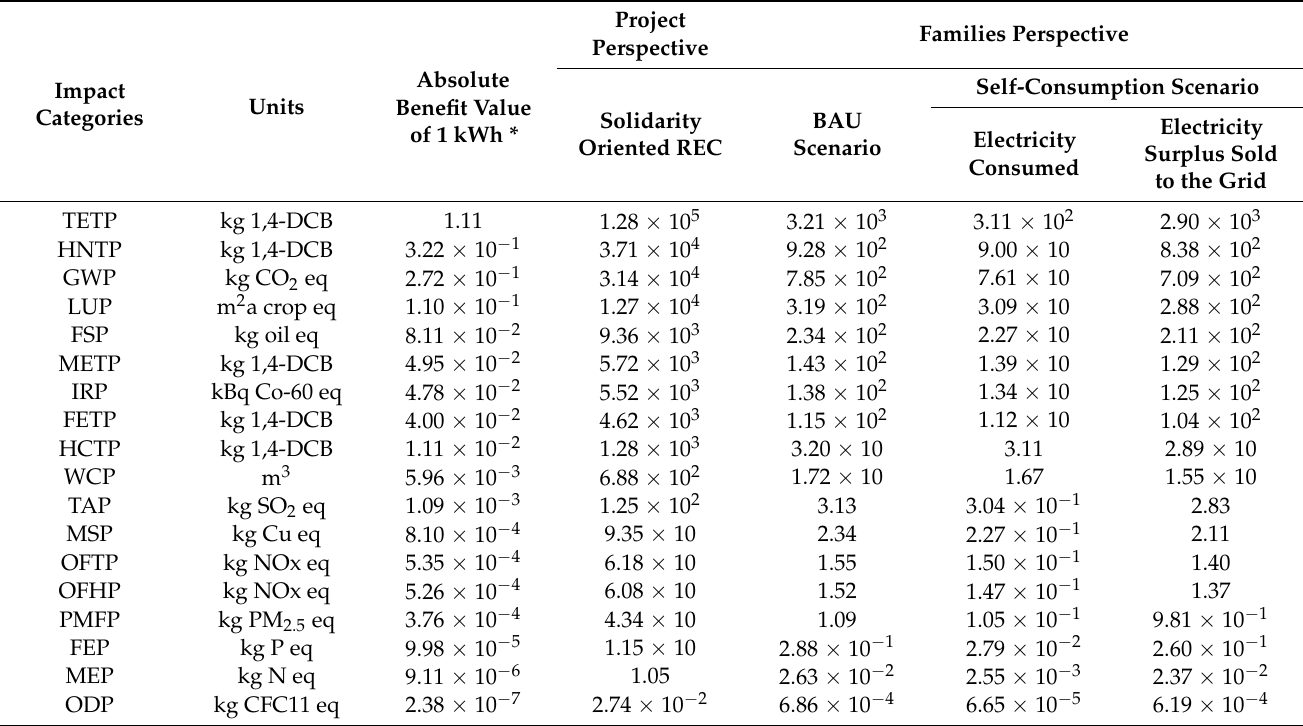
Table 6. Annual environmental benefits are sorted in descending order of absolute benefit